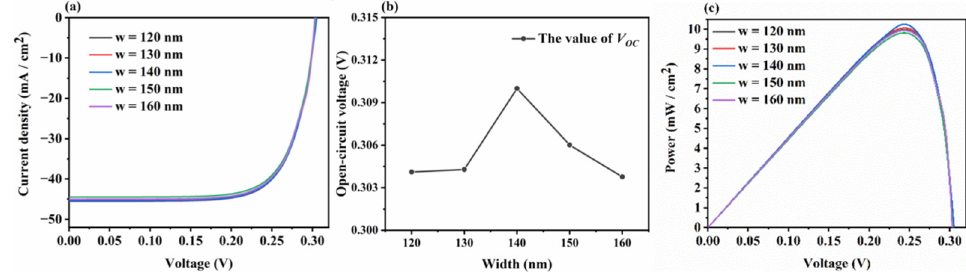
Figure 4. ( a ) J ‐ V curve under different cross ‐ cone widths. ( b ) Influence of cross ‐ cone width on V OC . Figure 4. ( a ) J-V curve under different cross-cone widths. ( b ) Influence of cross-cone width on V OC . ( c ) Output power curve under different cross ‐ cone widths. ( c ) Output power curve under different cross-cone